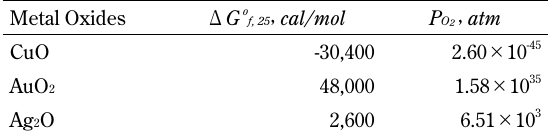
Table 3 Gibbs standard free energy for copper, gold, and silver oxides and partial pressure of oxygen required to stop oxidation at 25 ℃ . [Ther- modynamic values were taken from references 19,20 ） ] Metal Oxides